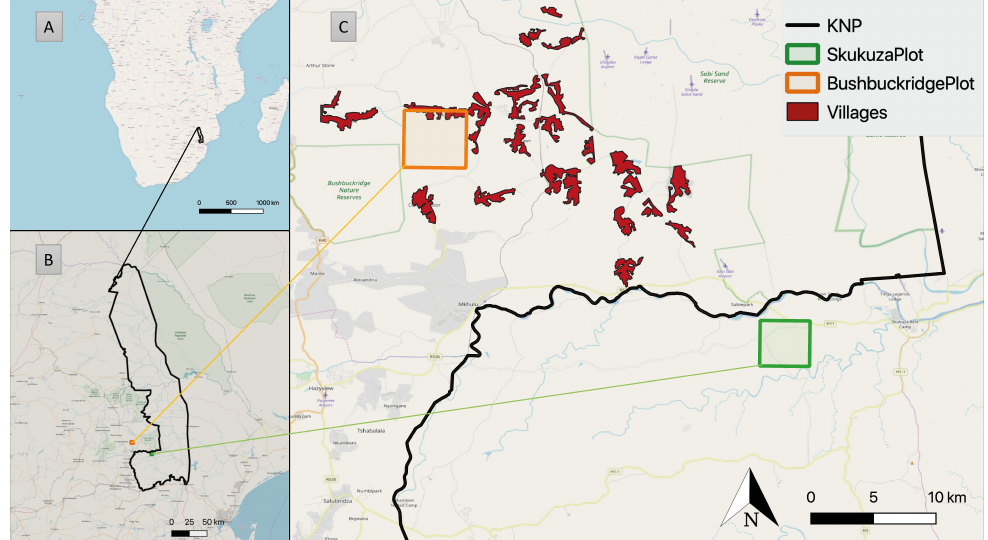
Figure 2. Study site: Overview of Southern Africa showing ( A ) the location of the KNP, ( B ) the location of both study sites with respect to the KNP, and ( C ) the location of both study sites with respect to the adjacent KNP border and neighboring